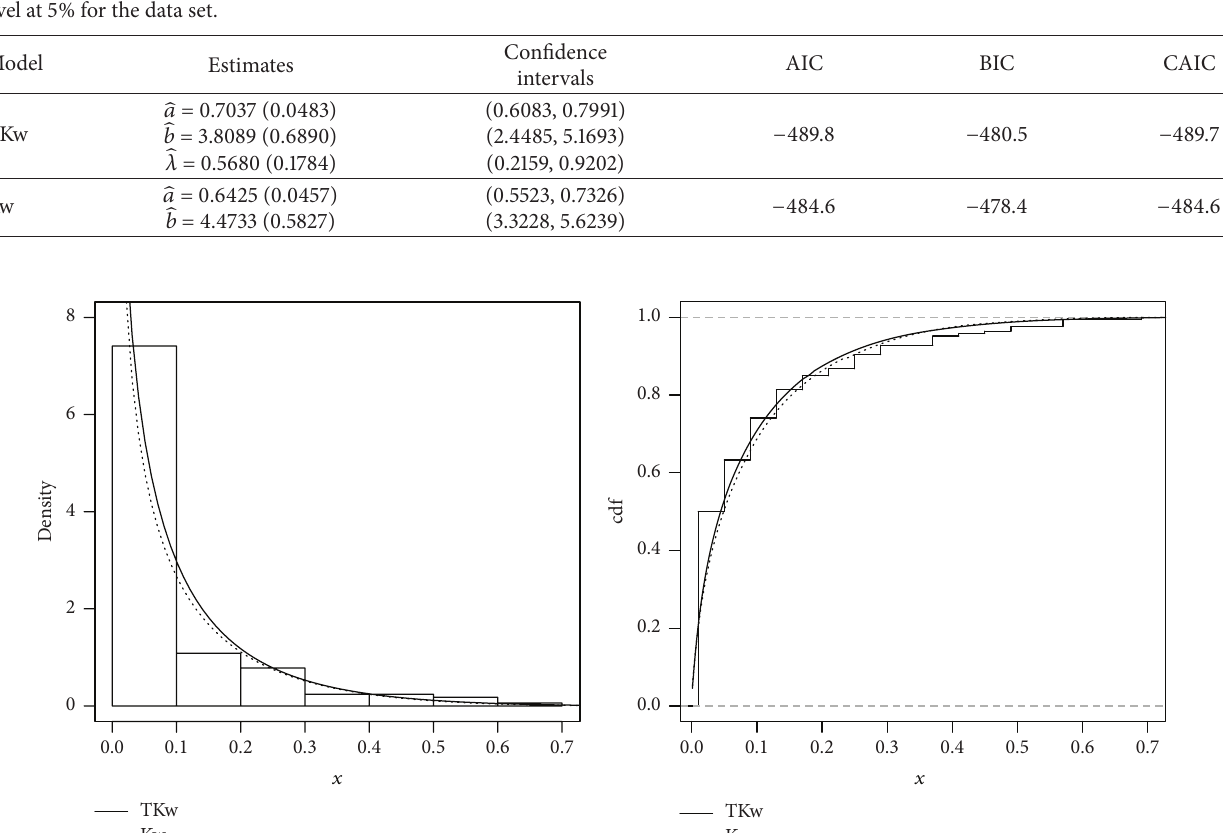
Figure 3: Estimated pdf and cdf from the fitted TKw and Kw models for the